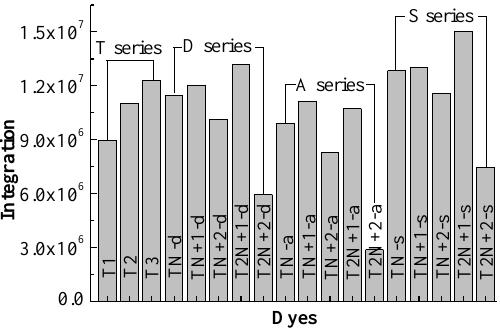
Figure 3. The integral area of absorption-wavelength curve over 400~800 nm.